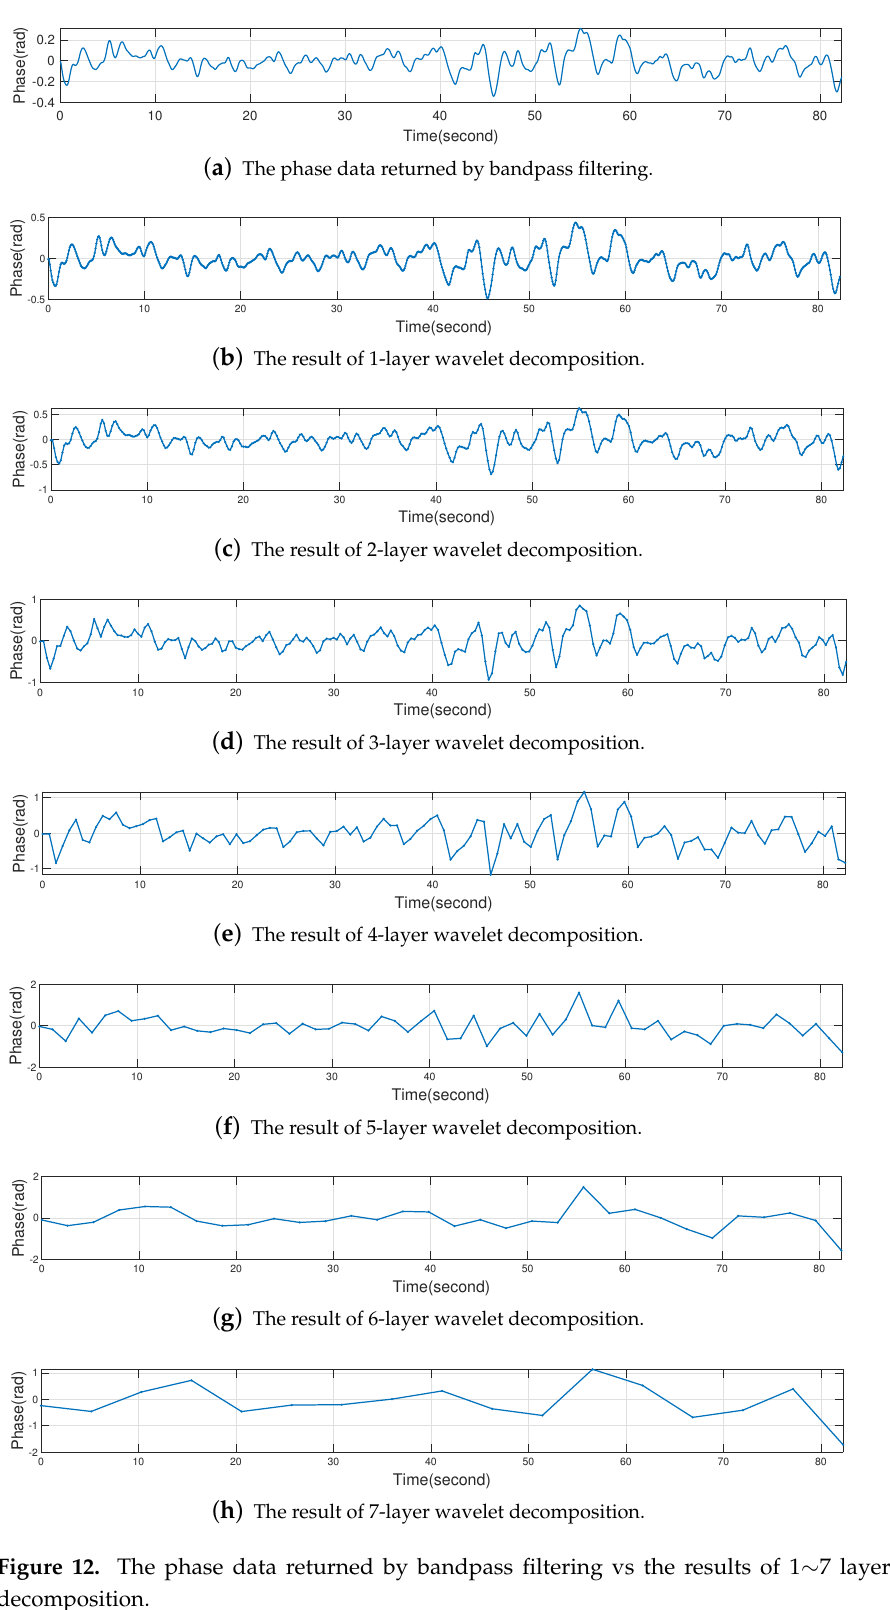
( h ) The result of 7-layer wavelet decomposition. Figure 12. The phase data returned by bandpass filtering vs the results of 1 ∼ 7 layer wavelet